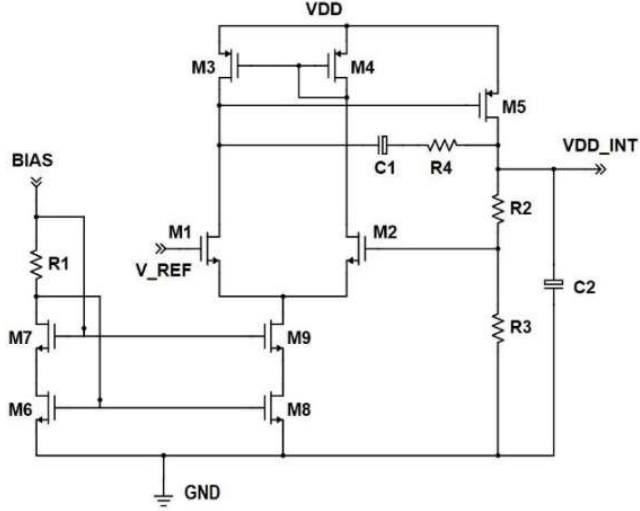
Figure 4. Low − dropout regulator Figure 4. Low−dropout regulator schematic.